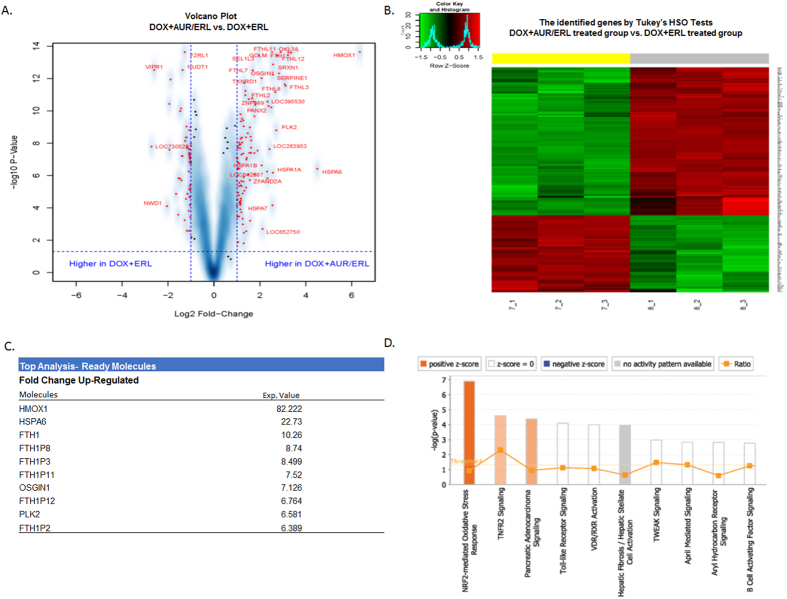
Gene expression profile and pathway analysis.Illumina array Human HT-12V4 expression bead chip platform was used across the Tet-inducible TUSC2 H1299 clone treated with auranofin-doxycycline-erlotinib vs doxycycline-erlotinib. Each treatment group was in triplicates. Beta-Uniform Mixture models were used to adjust for multiple comparisons. Significant genes were identified by One Way ANOVA, and Tukey’s HSD tests were used to analyze pairwise comparisons. Fold change larger than 2 or smaller than −2 were considered as significant at p < 0.05. (A) Volcano plot: 164 genes marked in red at FDR of 0.0001 were selected. (B) Heatmap: Genes with FDR of 0.0001 and fold change >2 were considered as significant genes. doxycycline-erlotinib: gray, auranofin-doxycycline-erlotinib: yellow. (C) List of top genes significantly upregulated between binary and trinary combination treatment. (D) Ingenuity pathway analysis Pathway analysis based on statistical significance and strength of association with extracts revealed the highest positive z-score for NRF2-mediated oxidative stress response.